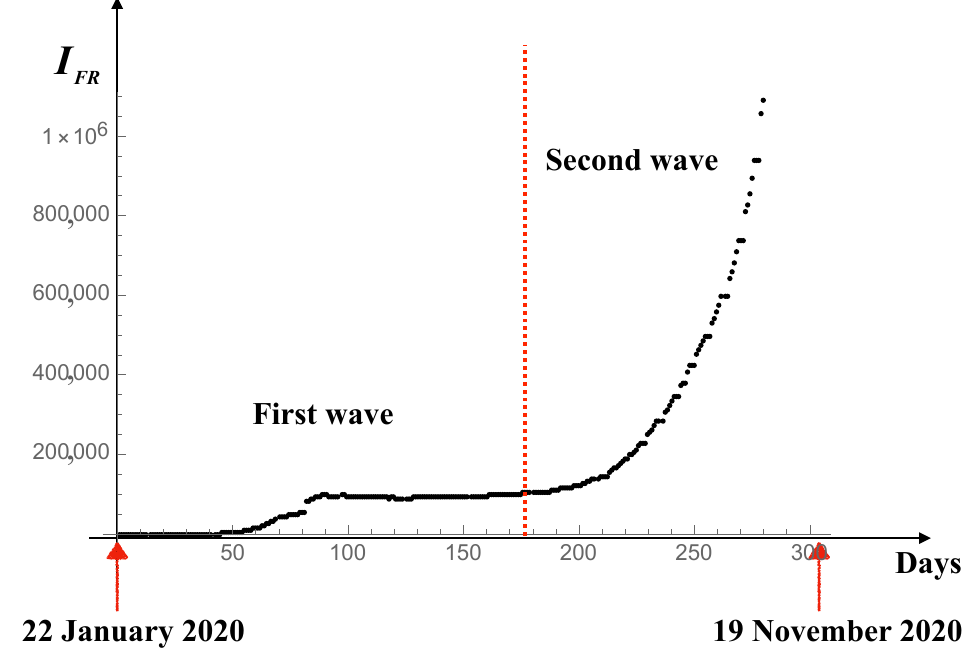
Figure 21. Number of infectious individuals by SARS-CoV-2 in